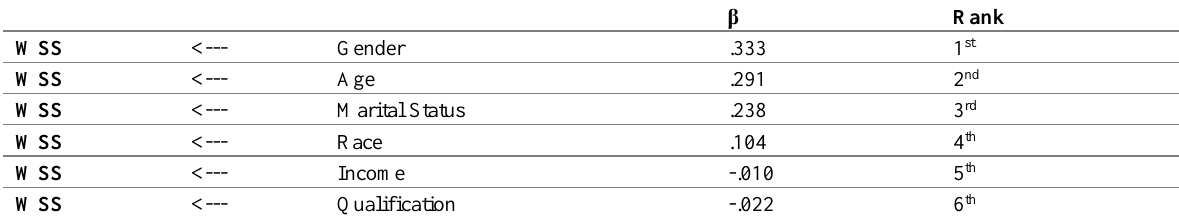
Table 2: Standardized coefficient of the demographic variable with the most significant influence on teachers’ work-stimulated stress. β Rank WSS <--- Gender .333 1 st WSS <--- Age .291 2 nd WSS <--- Marital Status .238 3 rd WSS <--- Race .104 4 th WSS <--- Income -.010 5 th WSS <--- Qualification -.022 6